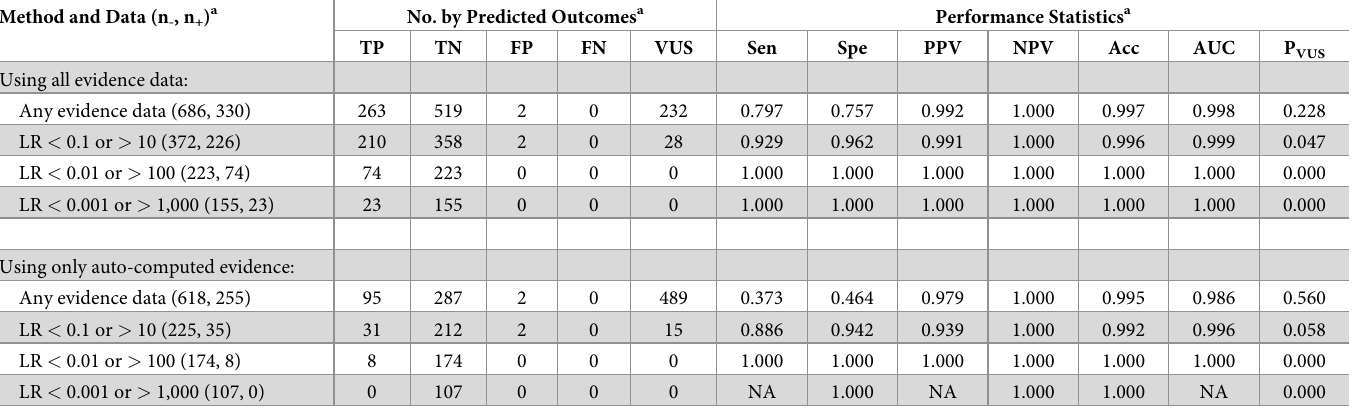
Table 2. Multifactorial variant prediction in MGPT